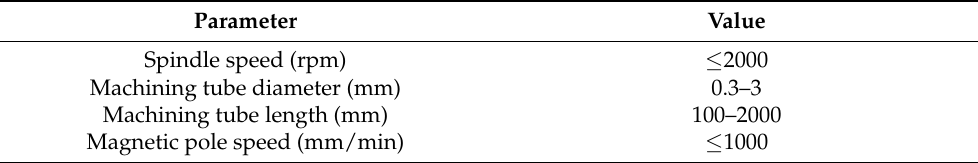
Figure 4. Ultra-slender cardiovascular stent tube inner wall magnetic particle finishing machine.